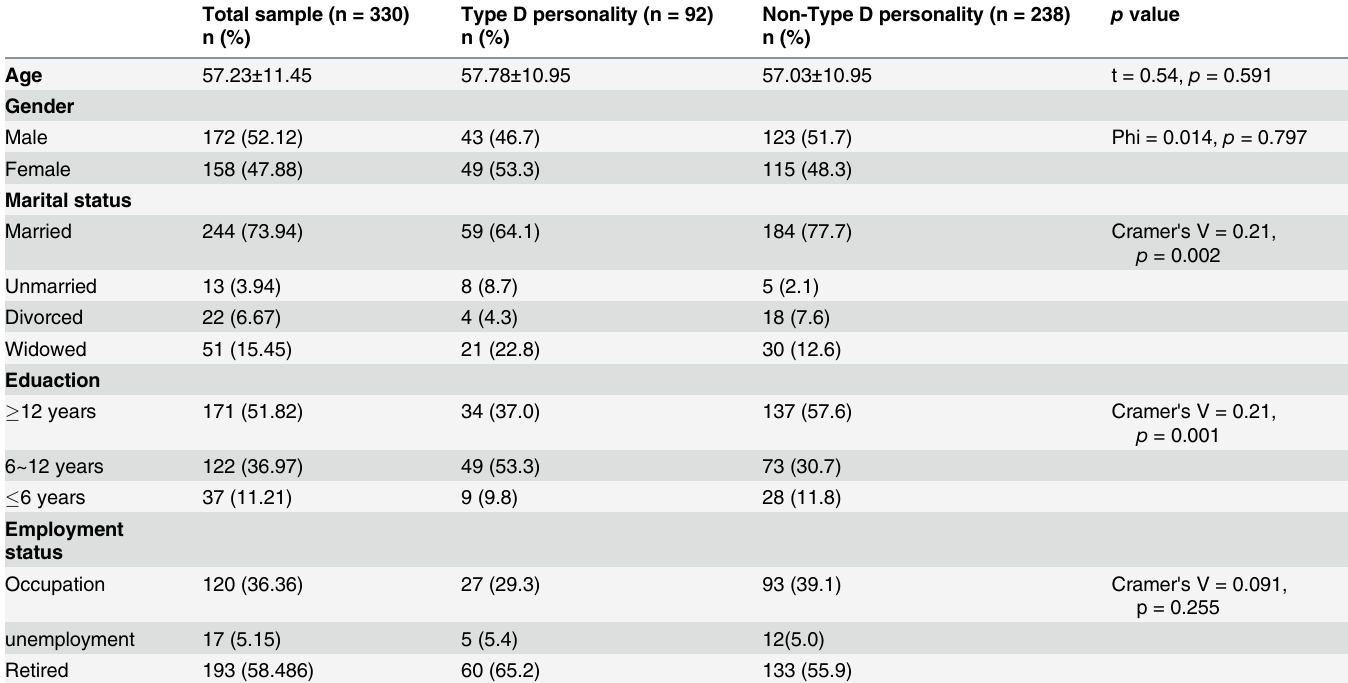
Table 1. Sample characteristics.